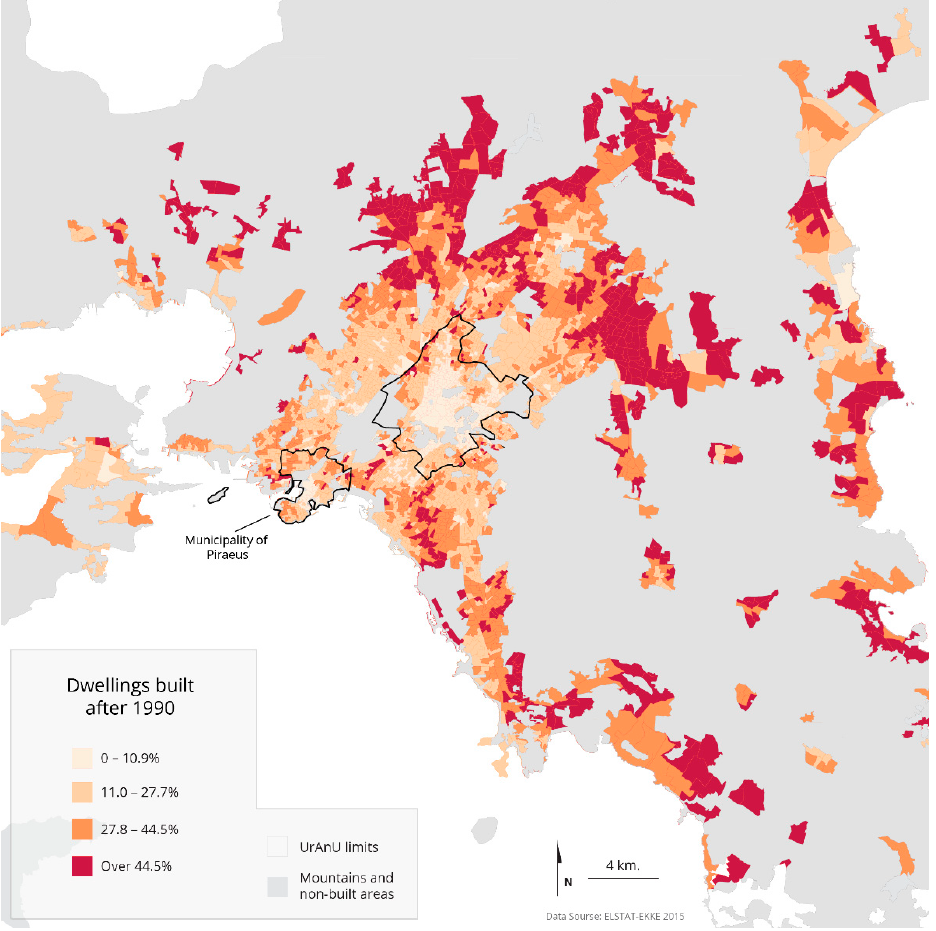
Figure 1. Age of dwelling stock: Percentage of dwellings built after 1990 by URANU (2011). Source: [8].